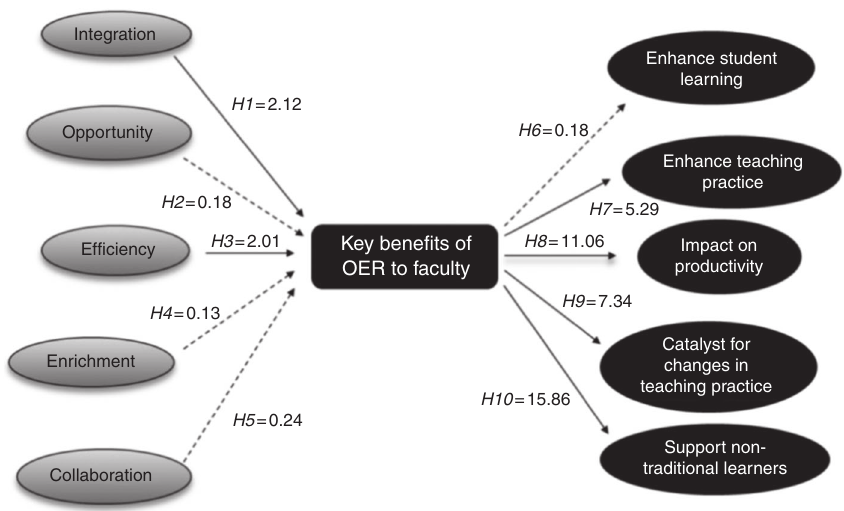
Table II. Respondents ’ characteristics